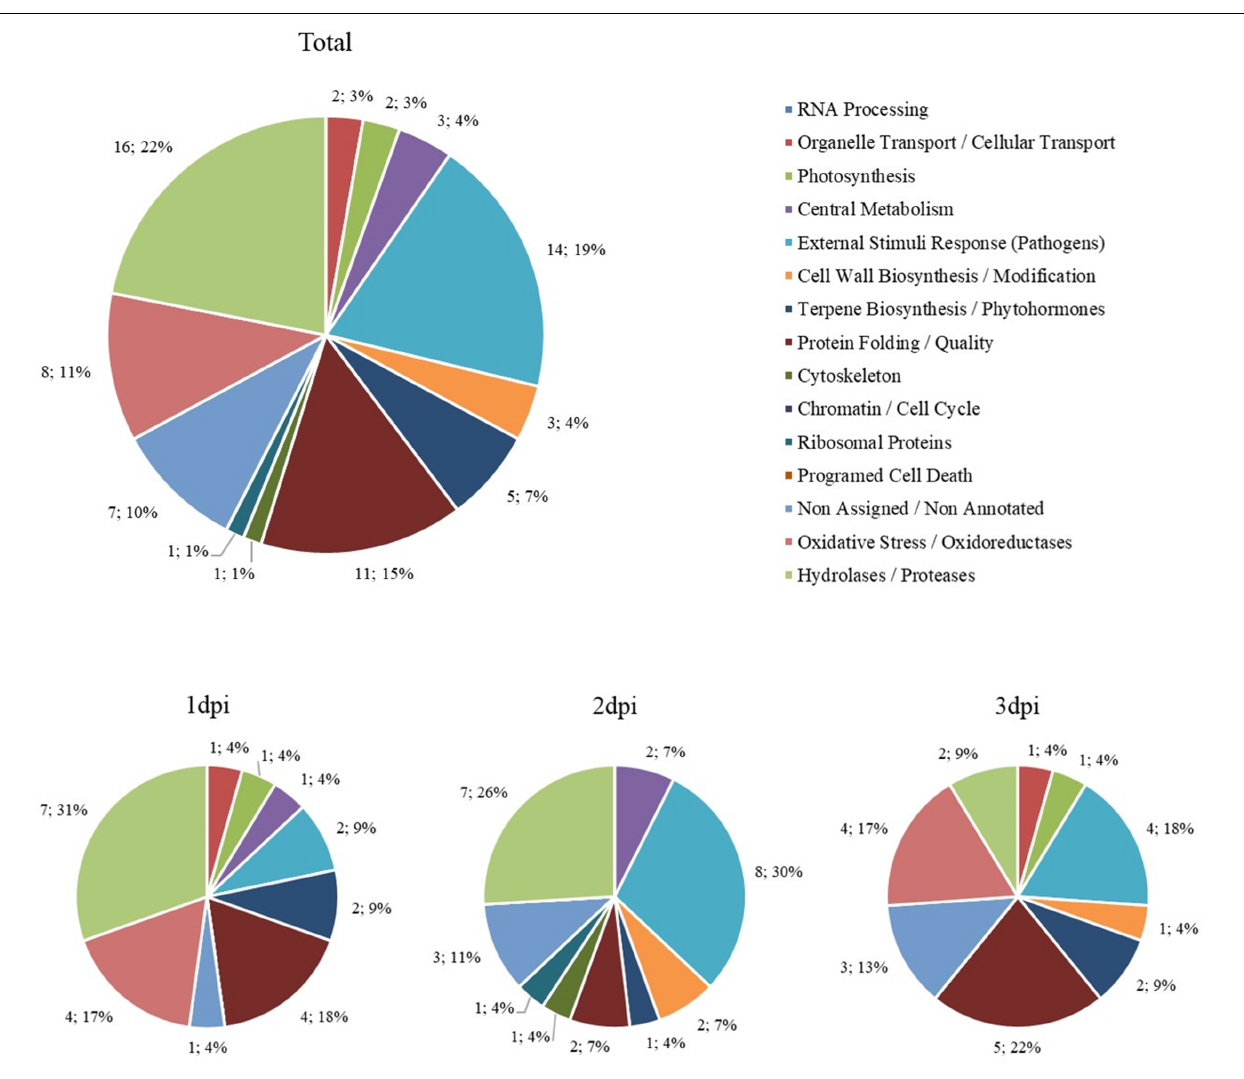
FIGURE 11 | Biological groups of less abundant proteins. The number of differentially less abundant proteins when comparing His.LotP with the control, represented by their biological group. Data are represented as the total amount and percentage of protein less over 3 days, as well as 1, 2, and 3 dpi. TABLE 2 | Plant protein responses to His.LotP over